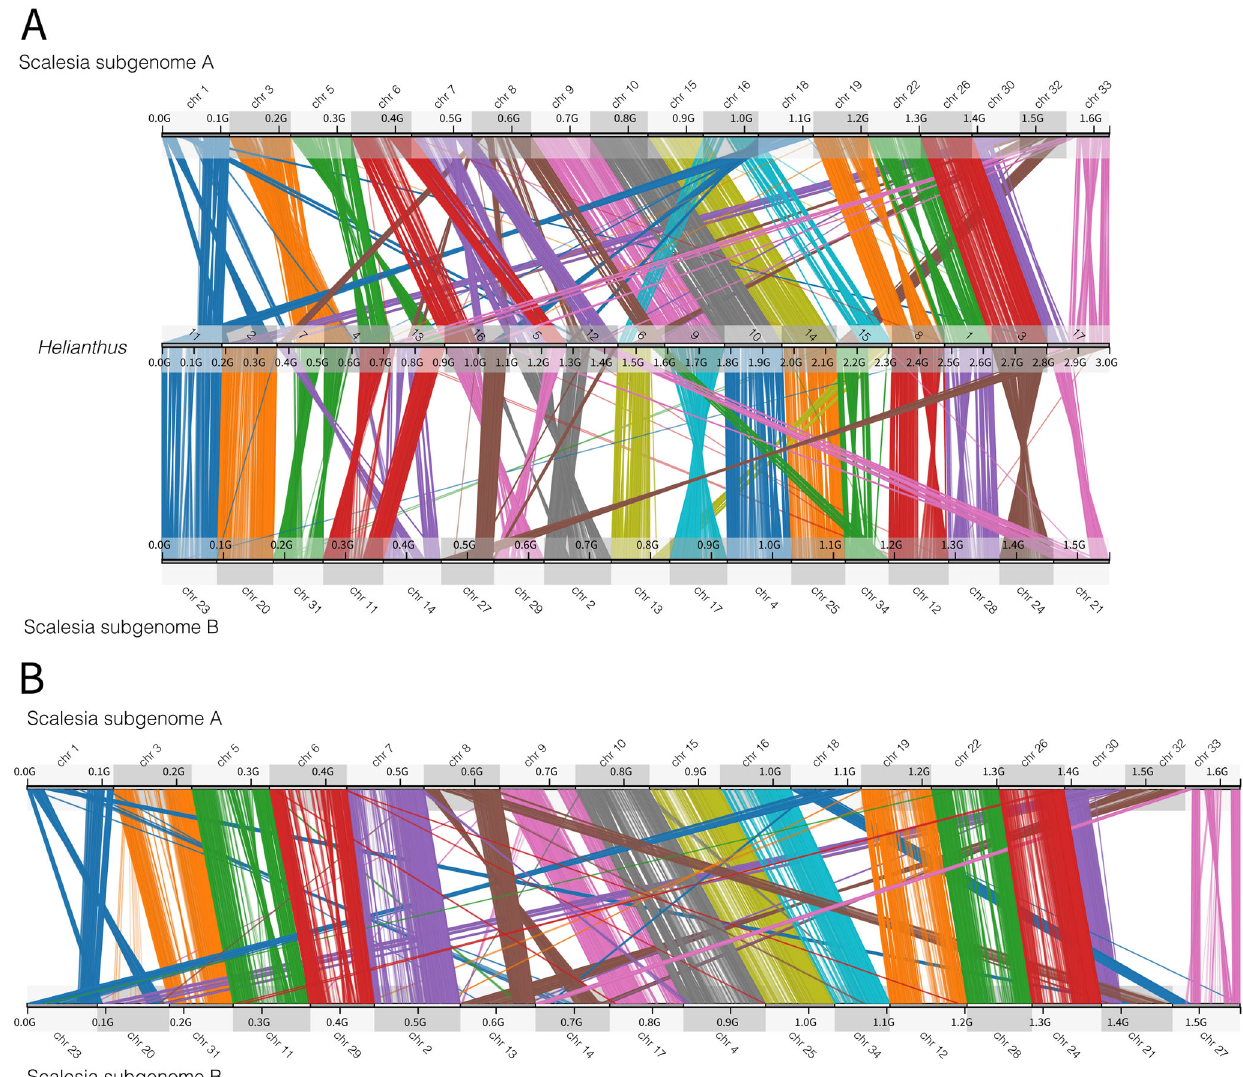
Fig. 4 Chromosome stability plots. These reveal the role of inversions and translocations in the differential in each subgenome. A Chromosome stability plot between the two Scalesia subgenomes and the Helianthus annuus genome. Each line connects a pair of orthologous genes, colour-coded by chromosome pair. B Chromosome stability between the two Scalesia subgenomes. Each line connects orthologous genes in subgenomes A and B, colour- coded by